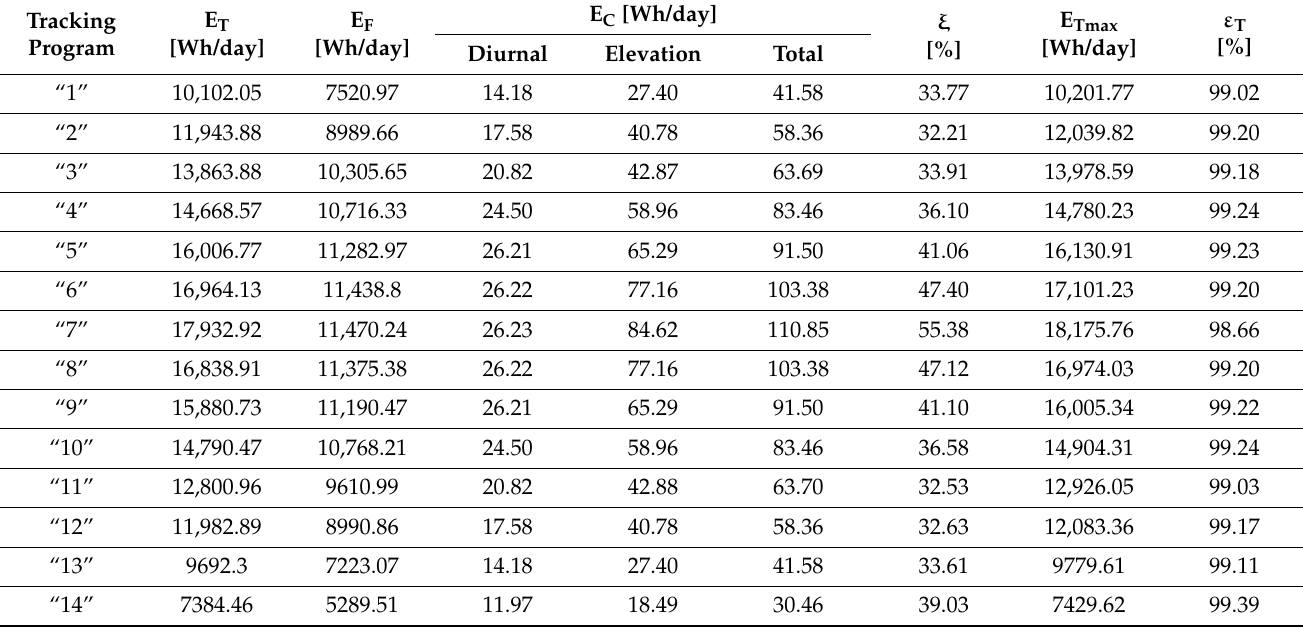
Figure 16. Numerical simulation results for tracking program “7”: ( a ) Platform’s angles; ( b ) Energy consumption for tracking; ( c ) Incident radiation; ( d ) Produced energy. Table 10. The efficiency of the bi-axial solar